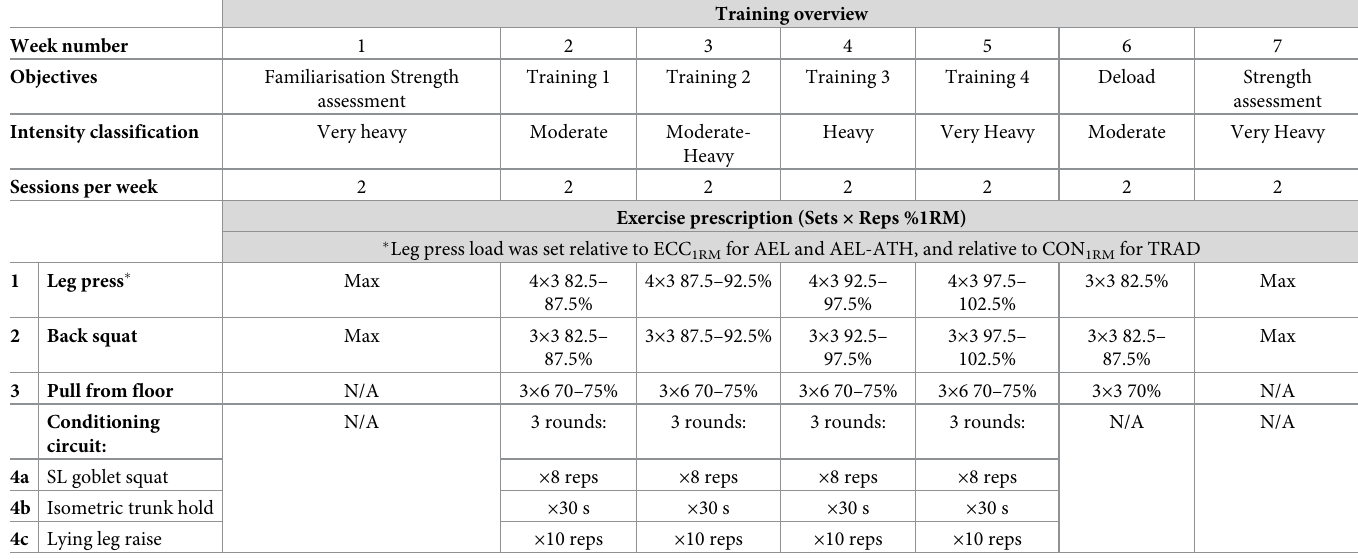
Table 2. Overview of the training intervention. The AEL and AEL-ATH groups performed leg press exercise with an augmented eccentric (ECC) phase (the ECC inten- sity was set relative to maximum ECC strength). The TRAD group performed leg press exercise in a traditional manner where both concentric (CON) and ECC phases were prescribed to CON repetition maximum